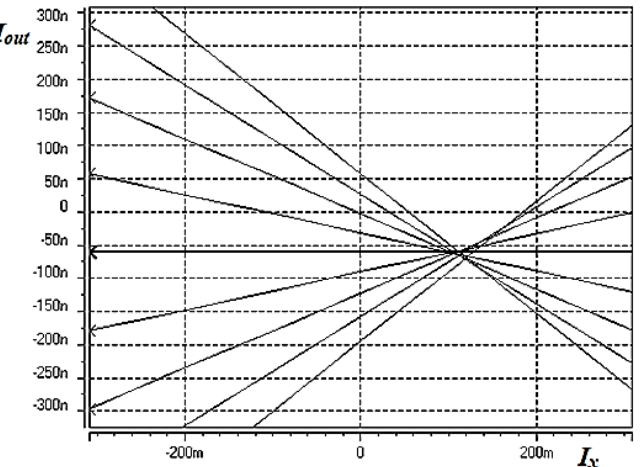
Figure 2. Simulated DC transfer characteristics (Iy is used as sweep parameter)